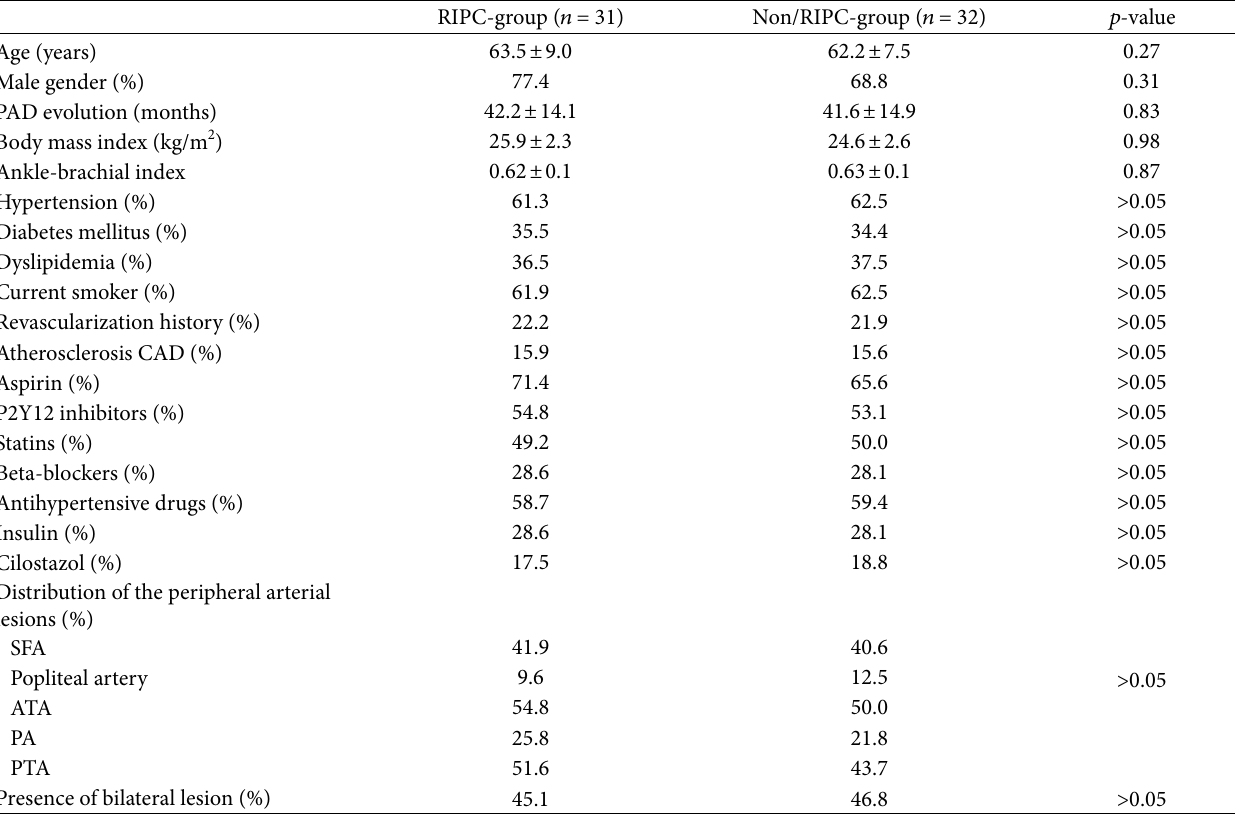
Table 1: General characteristics of patients with intermittent claudication.